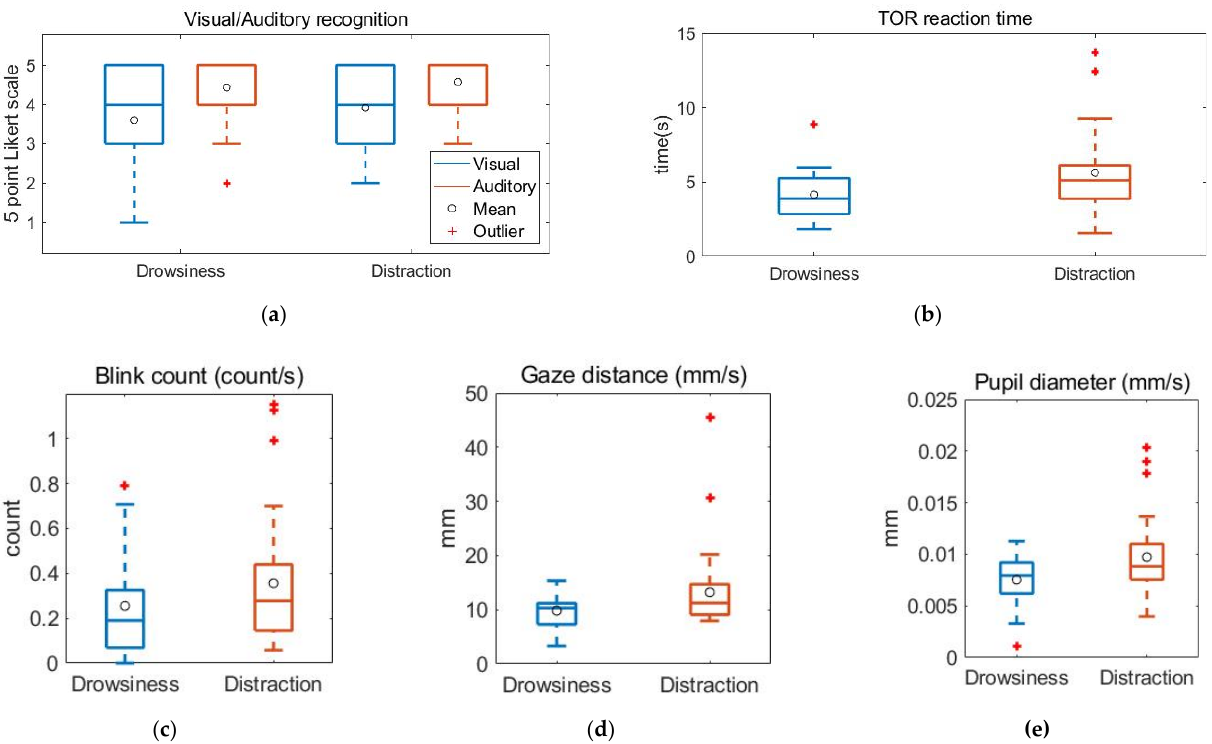
Figure 4. Boxplot of ( a ) visual and auditory recognition, ( b ) reaction time, ( c ) blink count, ( d ) gaze distance, and ( e ) changes in pupil diameter.